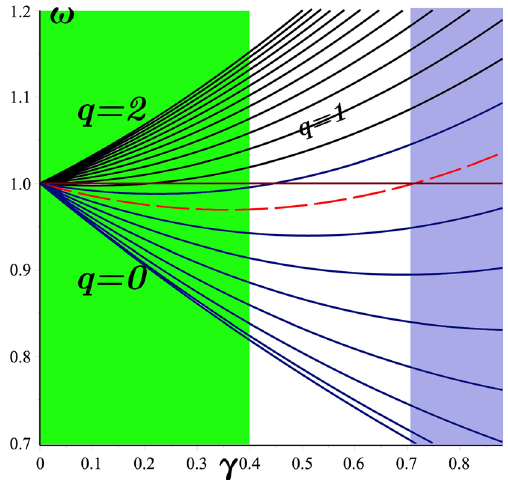
Fig. 3 The heat capacity C Q / Q 2 m in terms of x = r h (cid:5) √ (cid:6) 2 withequalsteps(frombottomtotop)and to γ = tanh − 1 2 0 . 2 . Please note that, the second branch of the heat capacity is not depicted